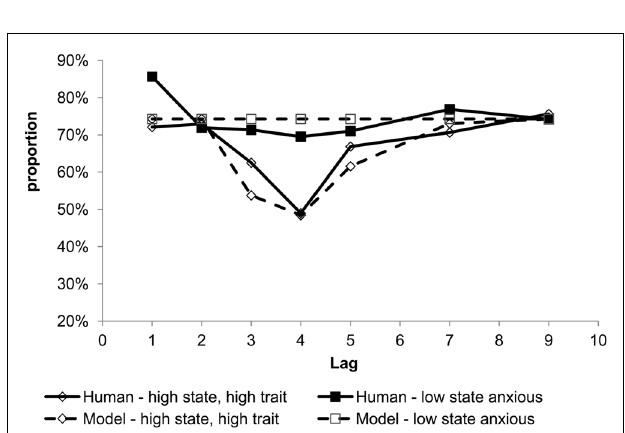
FIGURE 8 |Target report accuracy by serial position comparing human data (Barnard et al., 2005) and model simulations for high state and high trait anxious and low state